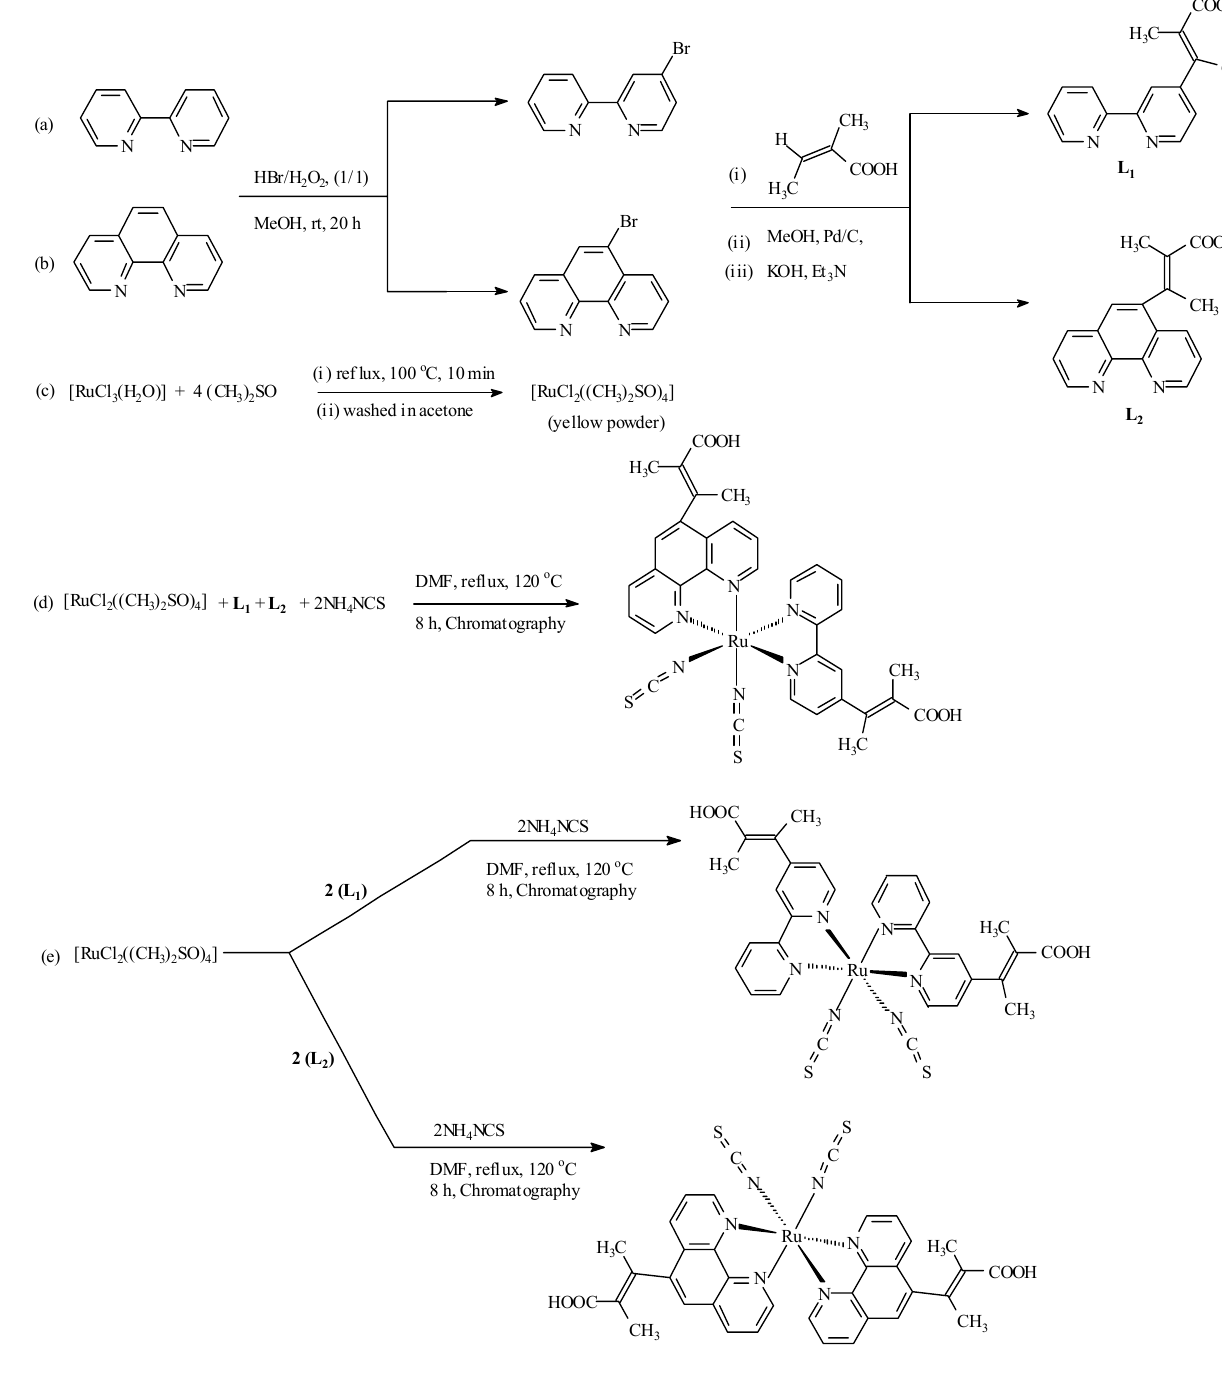
, L , and complexes [RuL 1 2